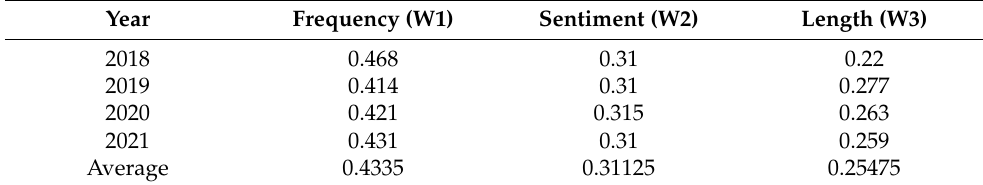
Table 7. Three-dimensional weight table in annual popularity